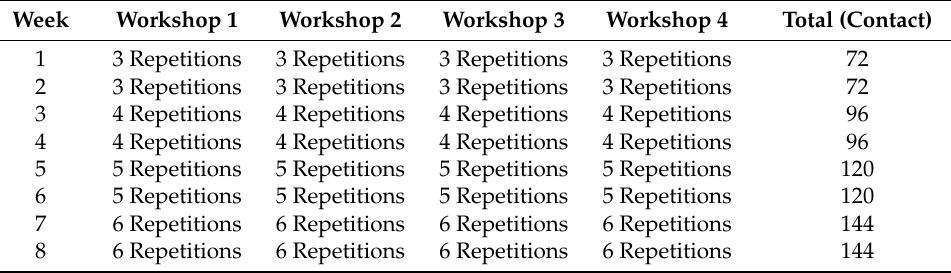
Table 2. Plyometric components introduced into the program of the experimental group.